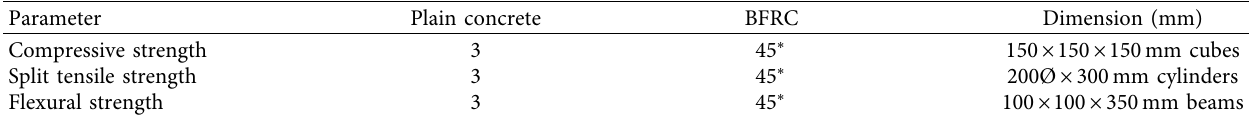
Table 7: Concrete specimens prepared for testing.